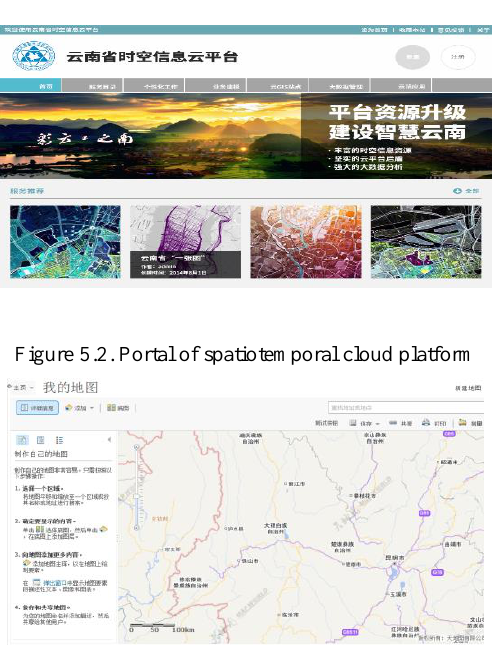
Figure 5.3. Cloud GIS services